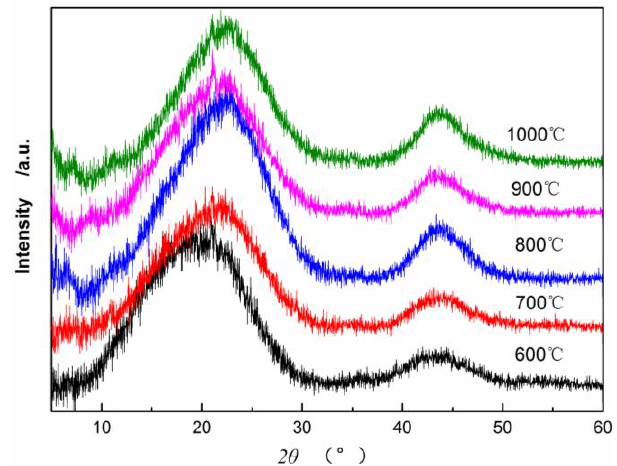
Figure 4. X-ray diffraction patterns of CBCFs at various temperatures.